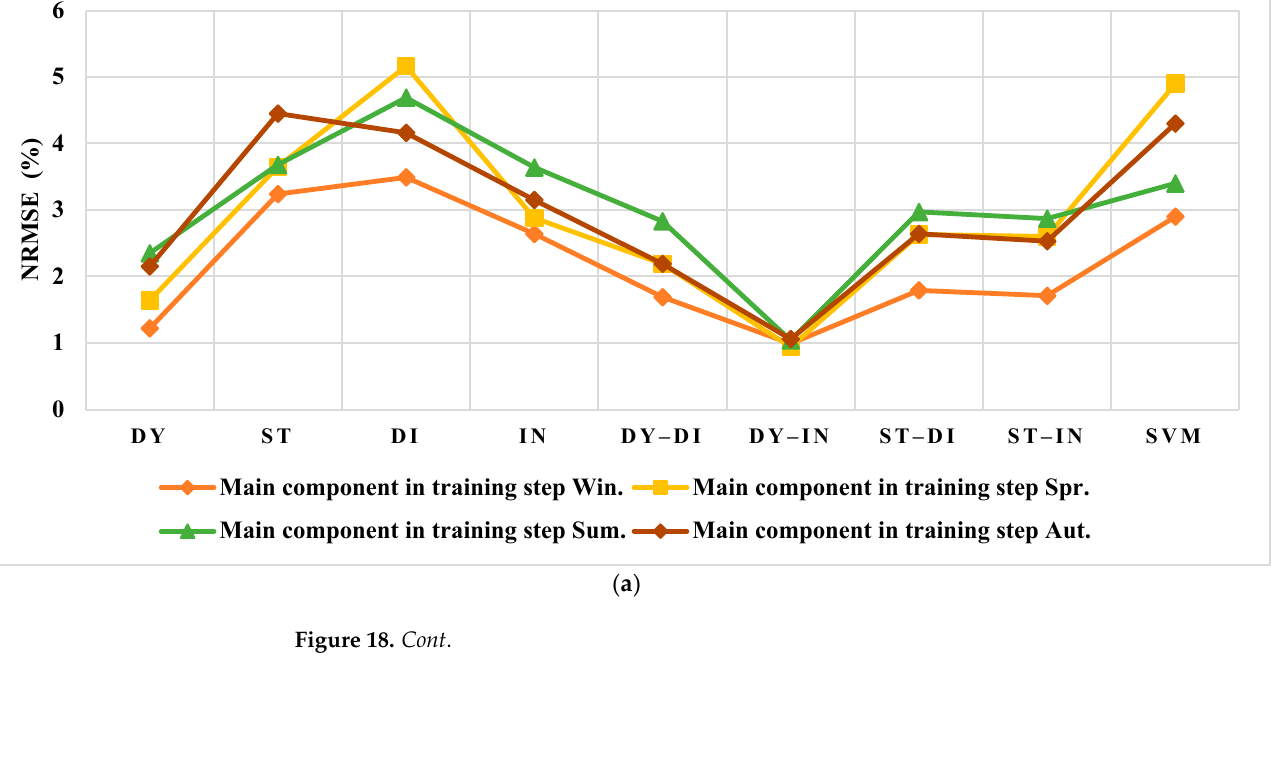
Test step Win. Test step Spr. Test step Sum. Test step Aut. Figure 17. The results of MAPE (%) for the US: ( a ) Main Component in training step, ( b ) Harmonic Component in training step, ( c ) Test step.